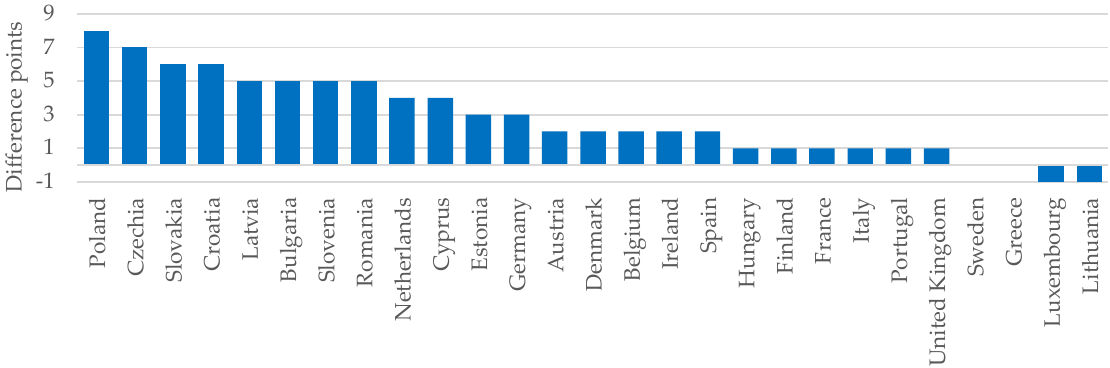
Figure 4. Changes in country score in 2019 compared to 2018. Source: authors’ computation .